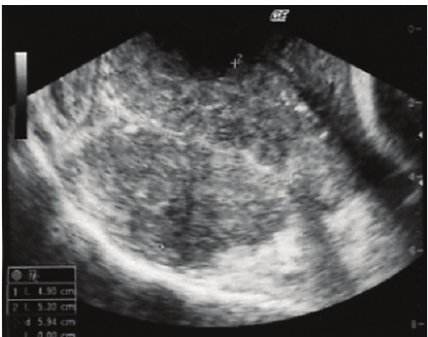
Figure 1: Vaginal ultrasonography demonstrated a 4.9 × 5.3 cm hypoechoic lesion behind the uterine